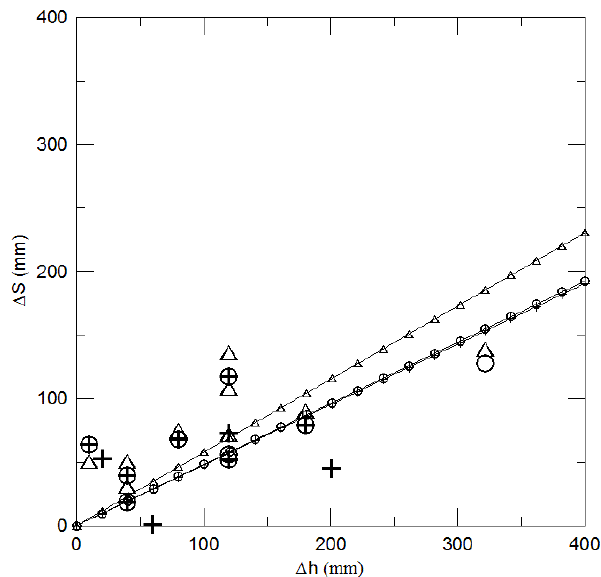
) with correction of Equation (1) (cid:35)